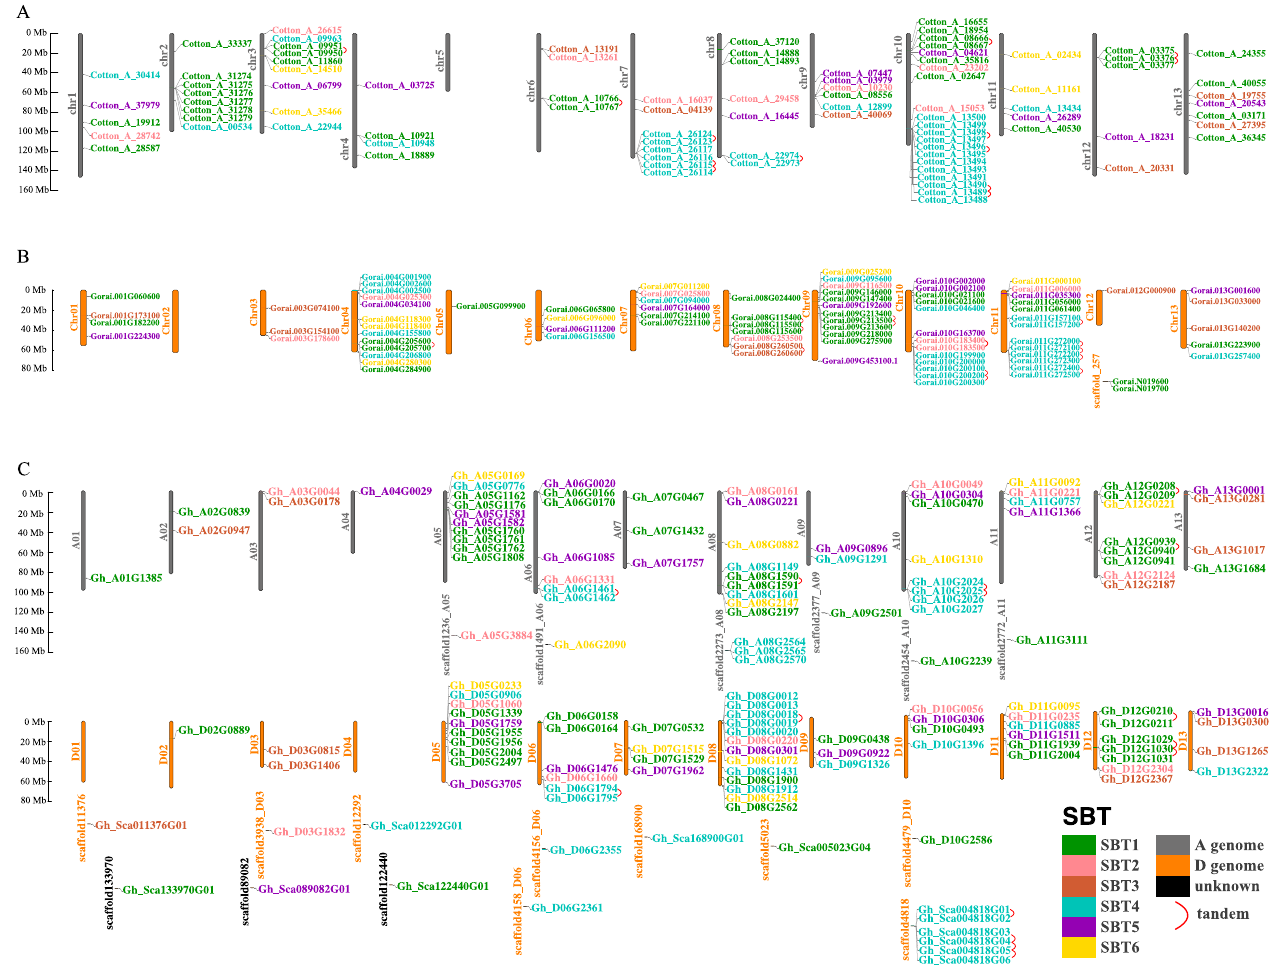
Figure 3. Chromosome positions of SBT gene family members in cotton. ( A ) Gossypium arboreum . ( B ) Gossypium Raimondii. ( C ) Gossypium hirsutum . The grey bars represent the chromosomes of the A subgenome. The orange bars show the chromosomes of the Gossypium Raimondii D subgenome. Black represents unpredicted subgenomic classifications. Different color gene names represent different classifications. Dark green, pink, brown, cyan, purple and dark yellow lines represent subfamilies from SBT1 to SBT6, respectively. The red curve connects tandem repeats, gene locations and chromosome sizes estimated in Mb on the left side of the figure.